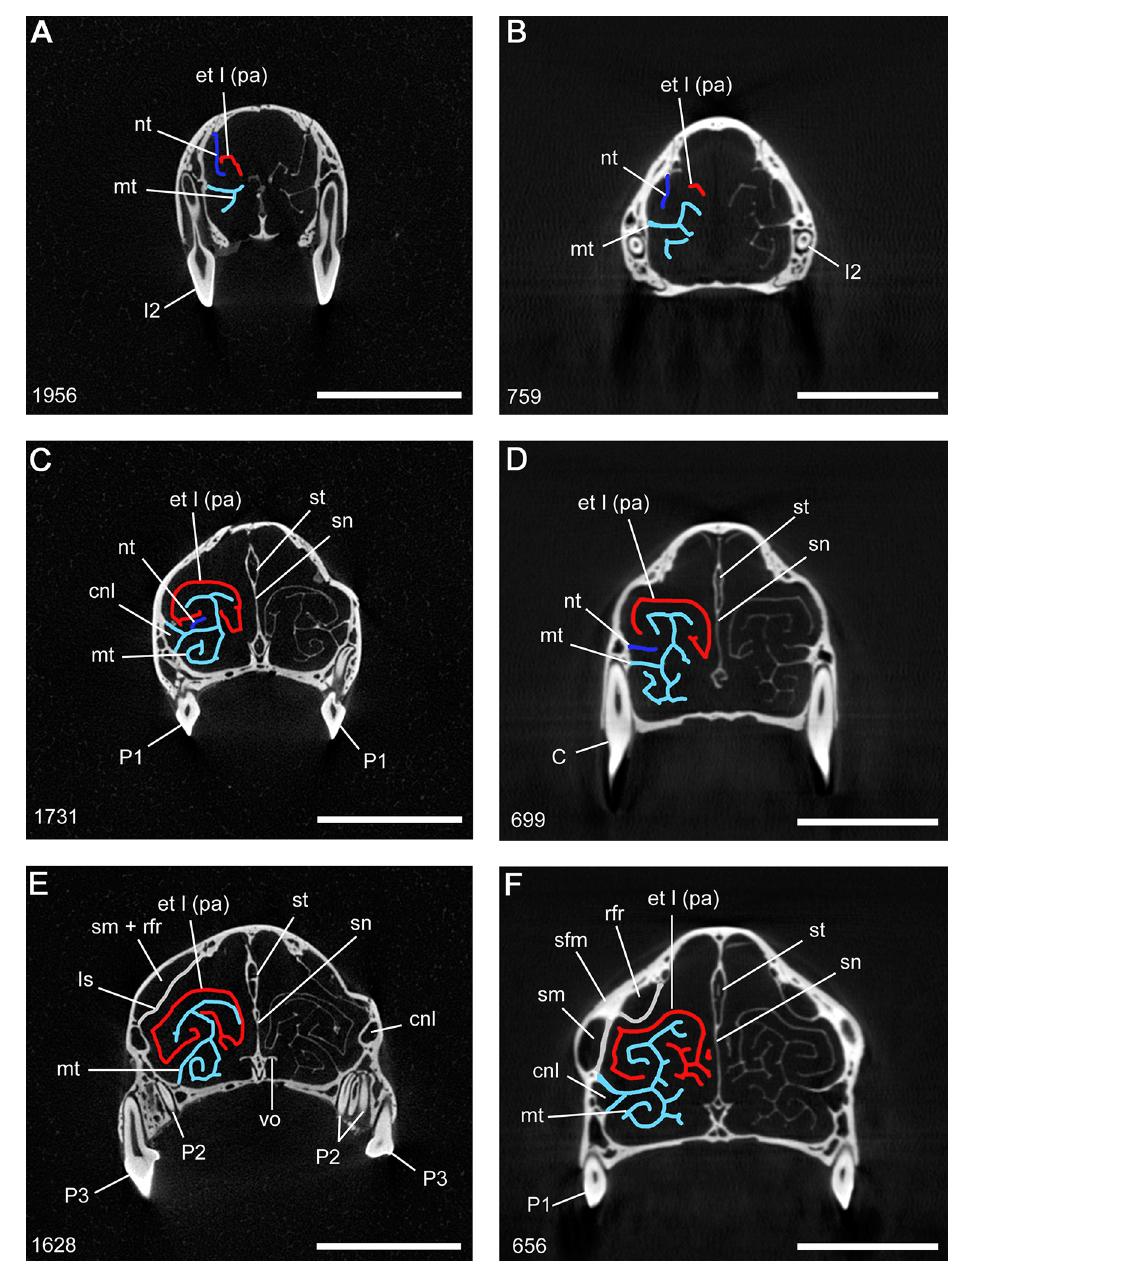
Figure 7. µCT cross-section images of the pars anterior of the adult rostrum from anterior to posterior of (a , c , e) Ptilocercus lowii (ZMB 3992) and (b , d , f) Tupaia sp. (collection W. Maier). Numbers in figures refer to number of original µCT slices. Abbreviations: C – upper canine; cnl, canalis nasolacrimalis; et I, ethmoturbinal I; I2, upper incisor 2; ls, lamina semicircularis; mt, maxilloturbinal; nt, nasoturbinal; P1, 2, 3, upper premolar 1, 2, 3; pa, pars anterior; rfr, recessus frontalis; sfm, septum frontomaxillare; sm, sinus maxillaris; sn, septum nasi; st, septoturbinal; vo, vomer. Scale bars equal